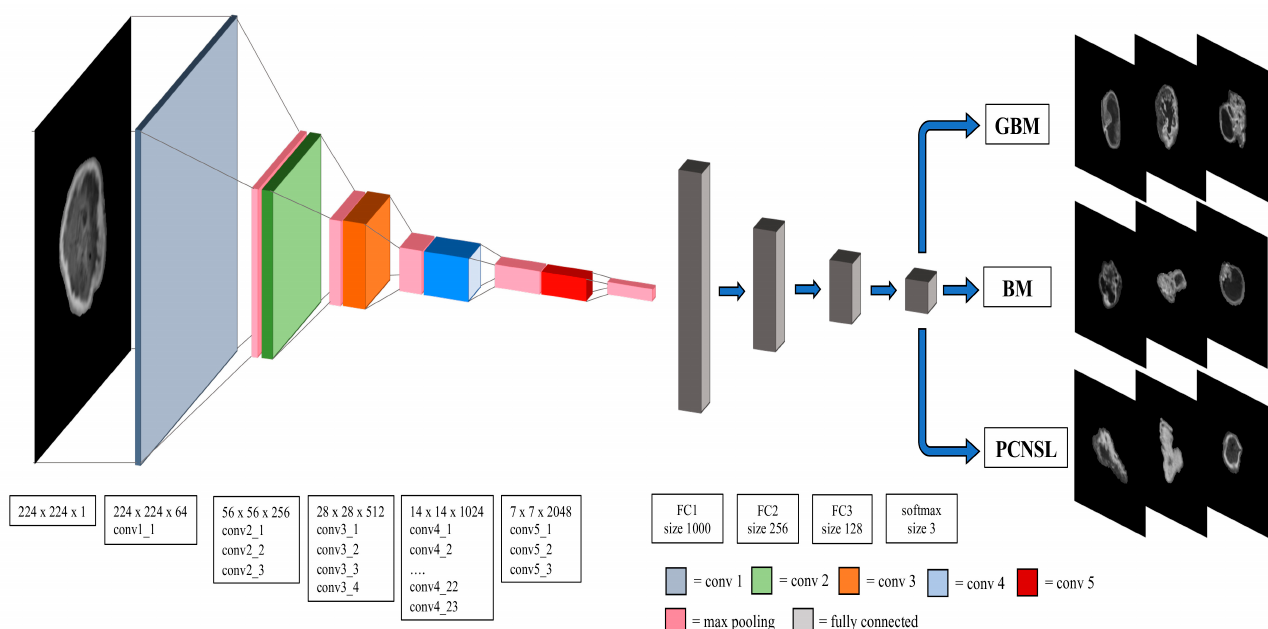
Figure 1. Model architecture trained as reported in Tariciotti et al. [13] and externally validated on the TeS dataset in the current study. The window size and stride for convolutional, maxpooling and fully connected layers are also presented. Conv: convolutional layer; FC: fully connected layer; GBM: glioblastoma; PCNSL: primary central nervous system lymphoma; BM: brain metastasis. “Reprinted with permission from Tariciotti et al. [13]. Copyright © 2022 Tariciotti, Caccavella, Fiore, Schisano, Carrabba, Borsa, Giordano, Palmisciano, Remoli, Remore, Pluderi, Caroli, Conte, Triulzi,